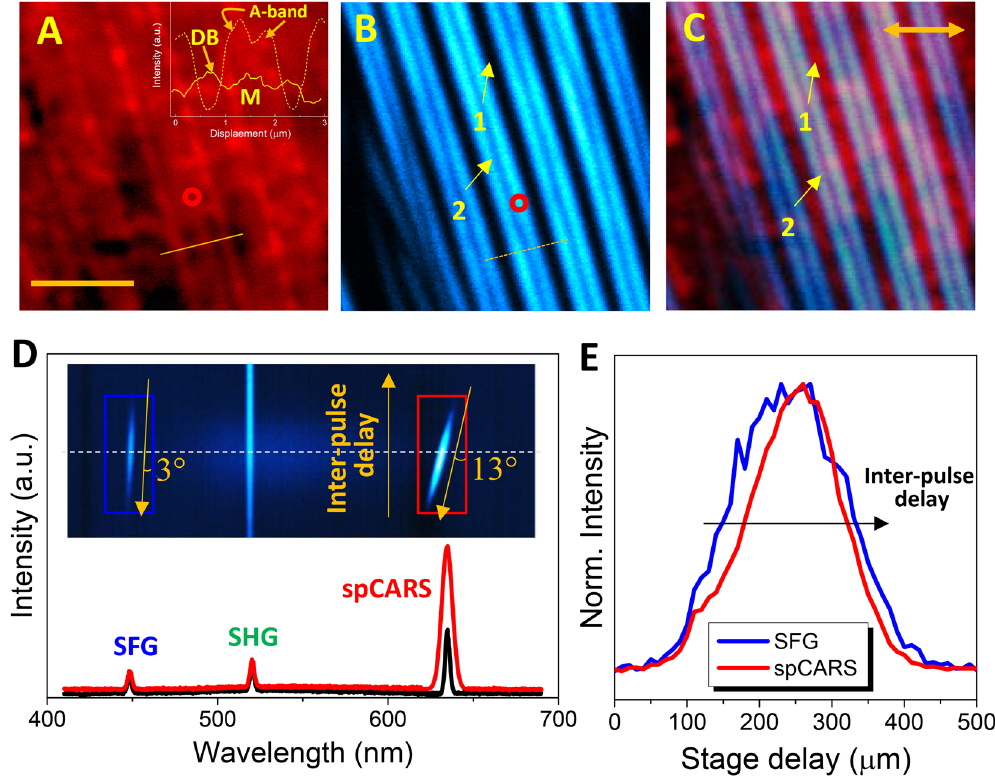
Figure 1. Spectrally focused CARS (spCARS) microspectroscopy assisted by SFG for C. elegans muscle subunits. Body wall muscle of WT C. elegans visualized using the (A ) spCARS and (B) SFG techniques. The scale bar in ( A ) represents 5 μ m, and the inset compares the line profiles along the solid and dotted lines in ( A ) and ( B ). (DB: dense body; M: M-line.) (C) Overlay image of ( A ) and ( B ). The two-headed arrow indicates the polarization direction of the two beams (pump and Stokes) and a polarizer located right before the detector (notice that the three are parallel). ( D) Wavelength spectra of WT C. elegans muscle (corresponding to the red circles in Fig. 1a, b and also to the white dashed line in the inset spectrogram) when the time delay is zero, in the presence (black) and absence (red) of a chirping glass. (E) SFG/spCARS spectra obtained from the blue (SFG) and red (spCARS) rectangles in ( D